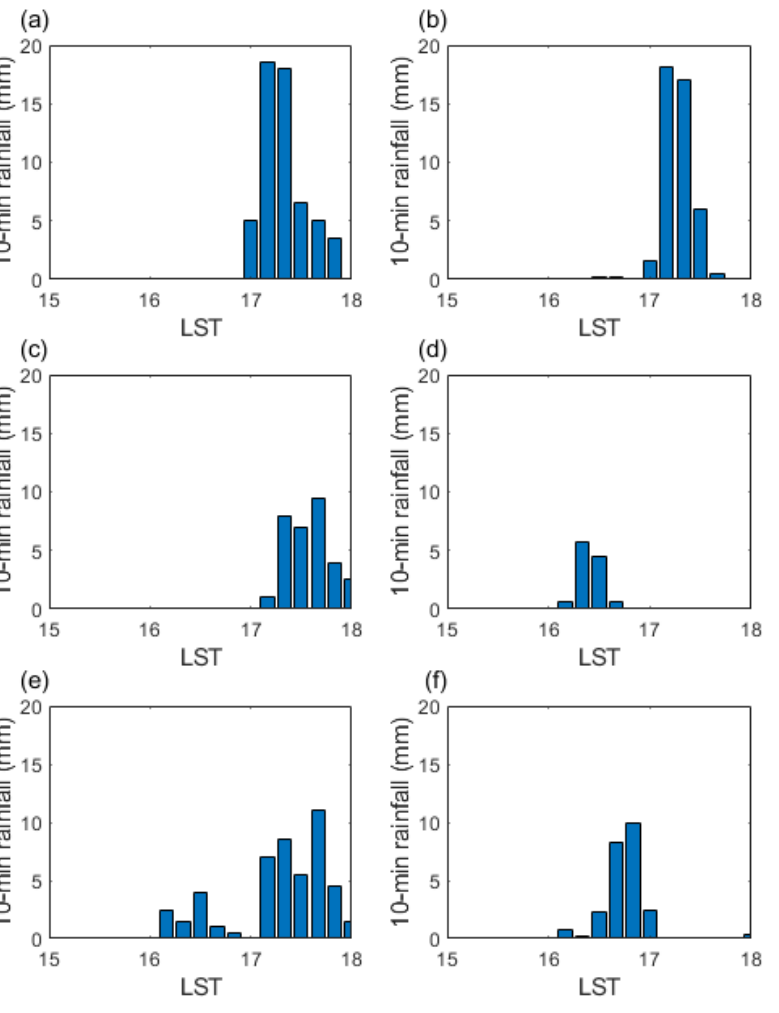
Figure 8. The time series of 10-min rainfall (mm) at the locations with maximum rainfall in north- eastern ( a , b ), south-center ( c , d ), and northwest ( e , f ) in the analysis domain. ( a , c , e ) Observation, ( b , d , f ) CNTL simulation from 1500 to 1800 LST on 6 July 2017.